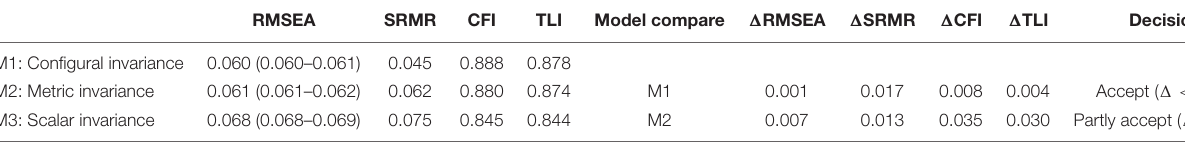
TABLE 6 | Multi-Group Confirmatory Factor Analysis (MGCFA) for six countries. RMSEA